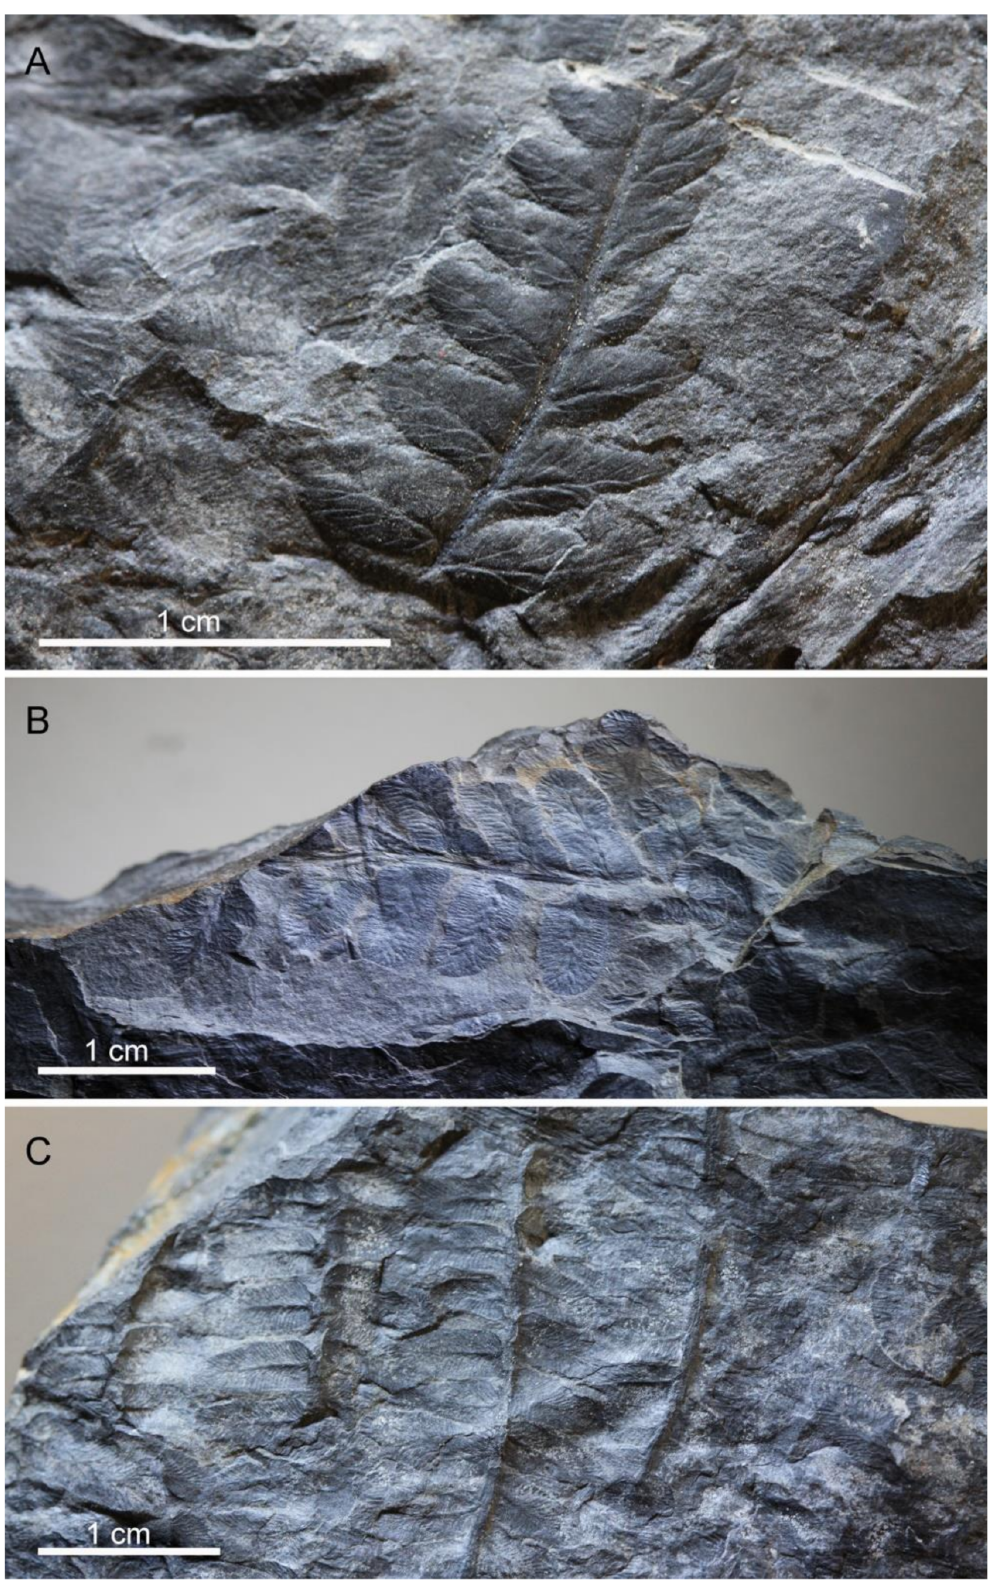
Figure 5. Plant remains recorded on side B of the slab containing the specimen (part) of the roachoid wing. ( A ) Oligocarpia leptophylla . ( B ) Lobatopteris corsinii . ( C ) Polymorphopteris polymorpha